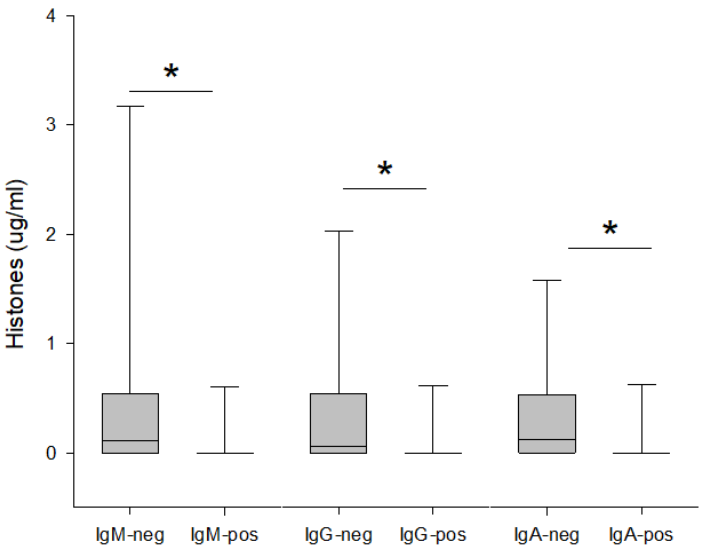
Figure 3. Concentration of Histones H3 in plasma in relation to positivity/negativity for SARS-CoV-2 antibodies in plasma. Antibody-positive: Before ICU discharge. Statistically significant differences between groups are marked by *.